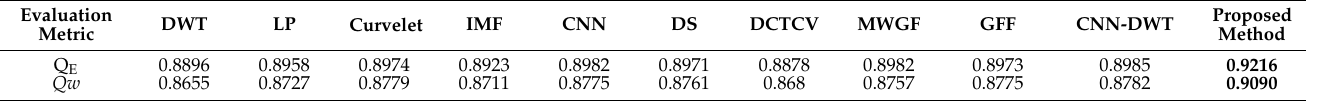
Table 12. The outcomes for the desk image and comparisons with existing techniques in the literature ([25]).